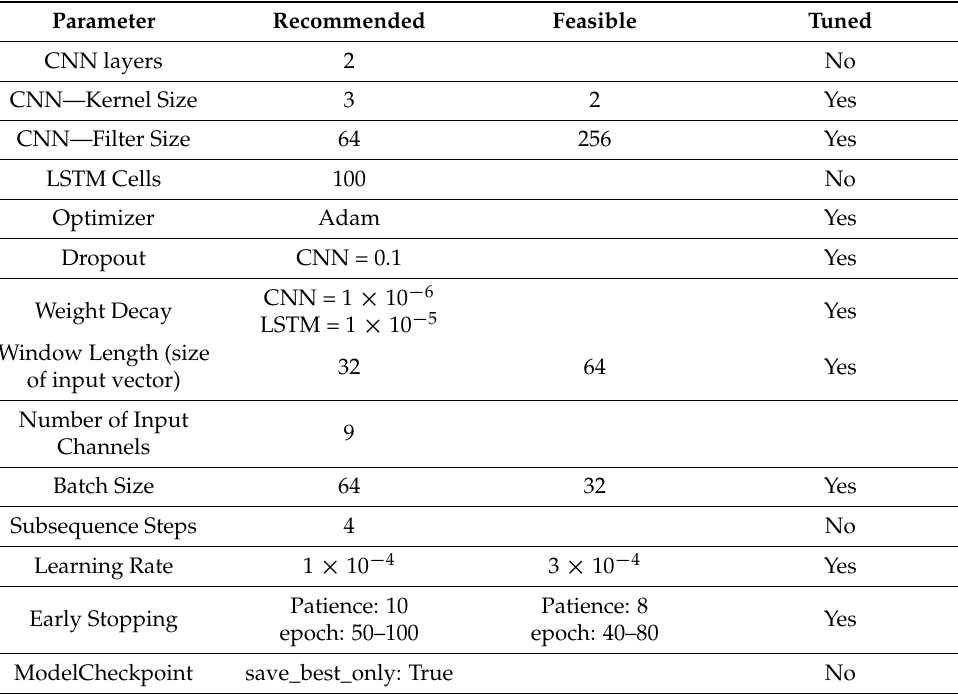
Table 3. Training parameters (tuned and default) configuration used for the baseline model. Parameter